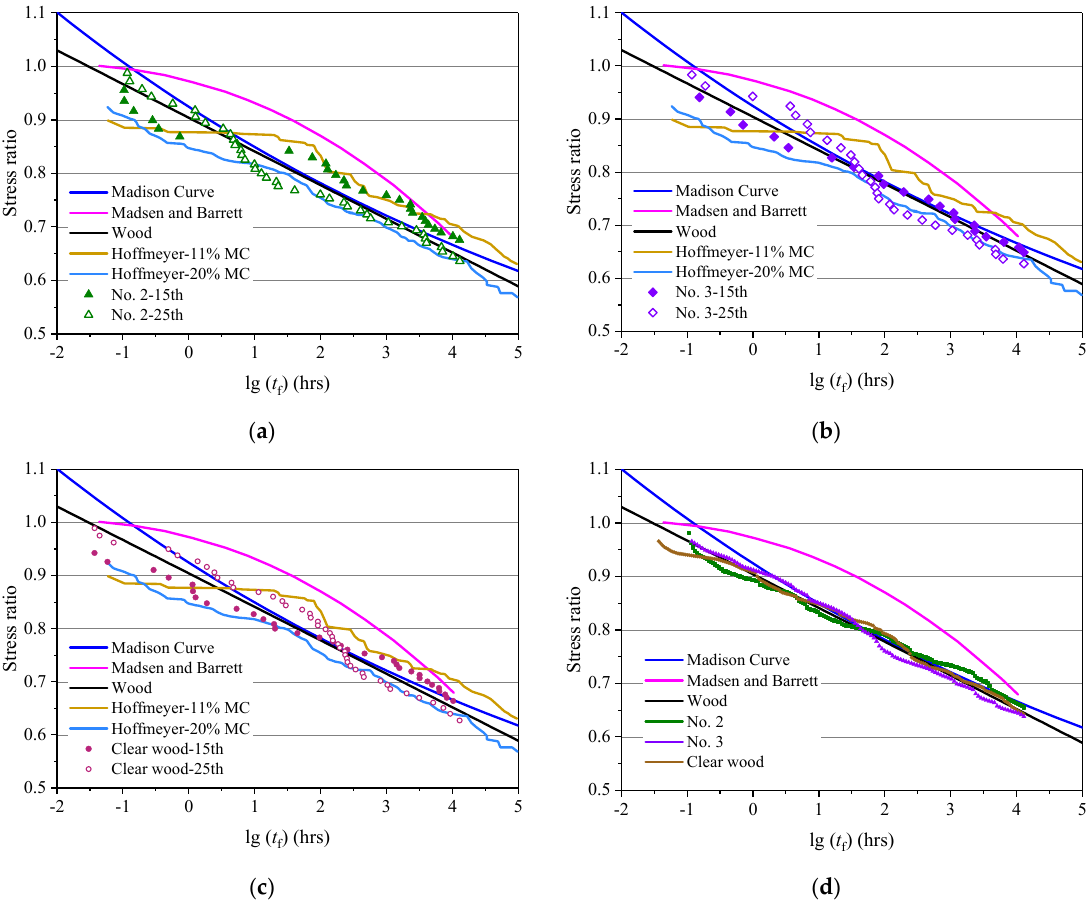
Figure 6. DOL obtained from the test. ( a ) Grade No. 2 dimension lumber, ( b ) Grade No. 3 dimension lumber, ( c ) Small clear specimen, ( d ) Averaged DOL between the two stress levels.